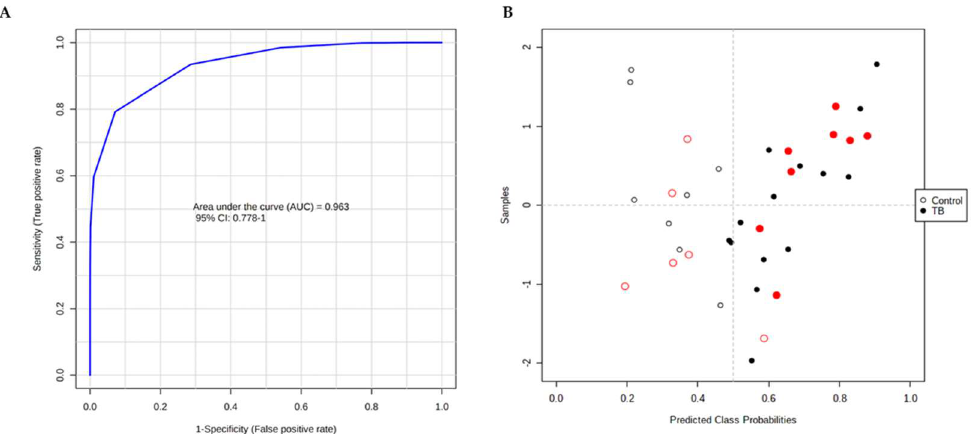
Figure 4. ROC constructed for the proteomic discovery set accurately assigns the validation set samples. ( A ) The combination of four proteins that presented an AUC above 0.92 (P01011, P00450, P08603, and P02790) were used to construct the ROC using a PLS-DA model with 3 latent variables. ( B ) Sample distribution within the model. Samples used for the model building in black and the hold-out samples in red. Open and filled circles represent control and patient samples, respectively.